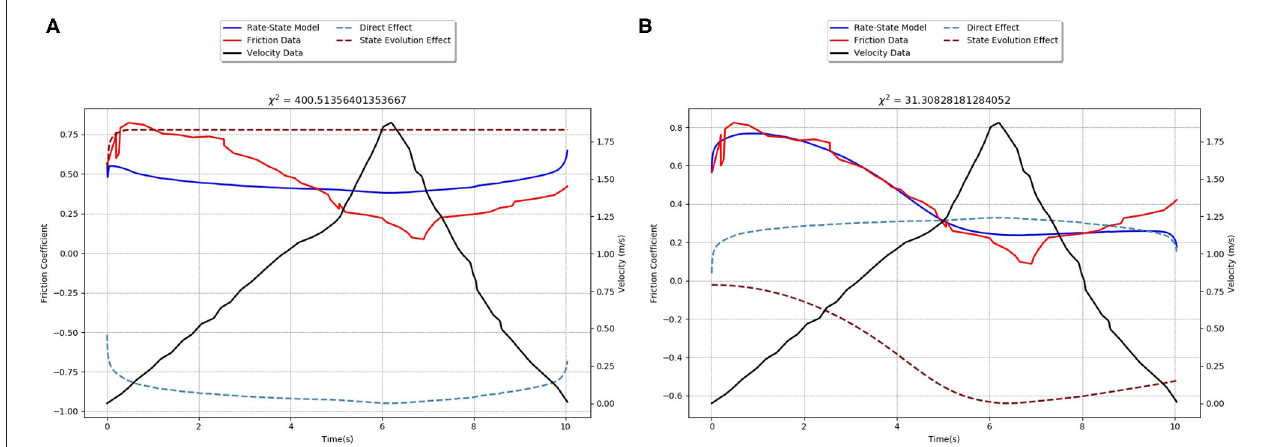
FIGURE 2 | Best-fitting models, with χ 2 -values given on top of the plots, for the Sone and Shimamoto (2009) steady acceleration/deceleration experimental data. RSF with restricted parameter ranges: (A) a and b [ − 0.03 to 0.03], D [ < 1mm], and v 0 [ < 10 − 4 m/s] are restricted to values consistent with low-velocity measurements, while in (B) only v 0 is restricted to this range. The solid red line is the frictional data; the solid blue line shows the inversion fit for each model; the solid black line is the driving velocity data which the interface is forced at; the dotted blue line is the direct effect term of each friction model; while the dotted brown line is the state evolution term. In order to best fit both terms on the plot with minimal overlap, they are offset. In RSF, µ 0 provides a natural offset, since the friction coefficient is the sum of the two terms and µ 0 (thus the friction coefficient curve is a summation of the two terms, as they are plotted, plus this additional offset). As expected, commonly used RSF parameters cannot capture the dynamic friction evolution at high-velocities, but with the parameters outside of these common ranges, the model is able to reproduce more of the observed frictional evolution